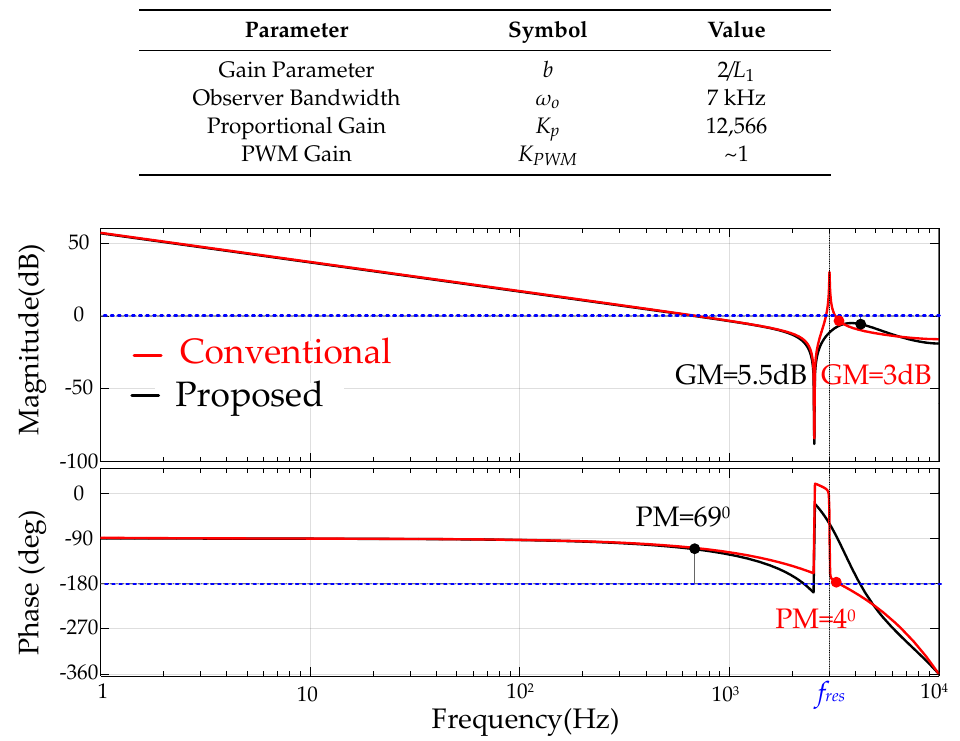
Figure 4. Frequency response of loop gain of mutual current under n = 2, 4, 8, 16, 32 and 64 with the conventional and proposed control scheme.